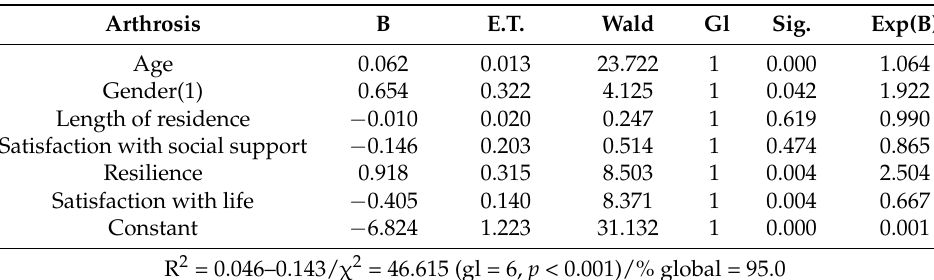
Table 4. Logistic regression analysis of arthrosis and back pain.